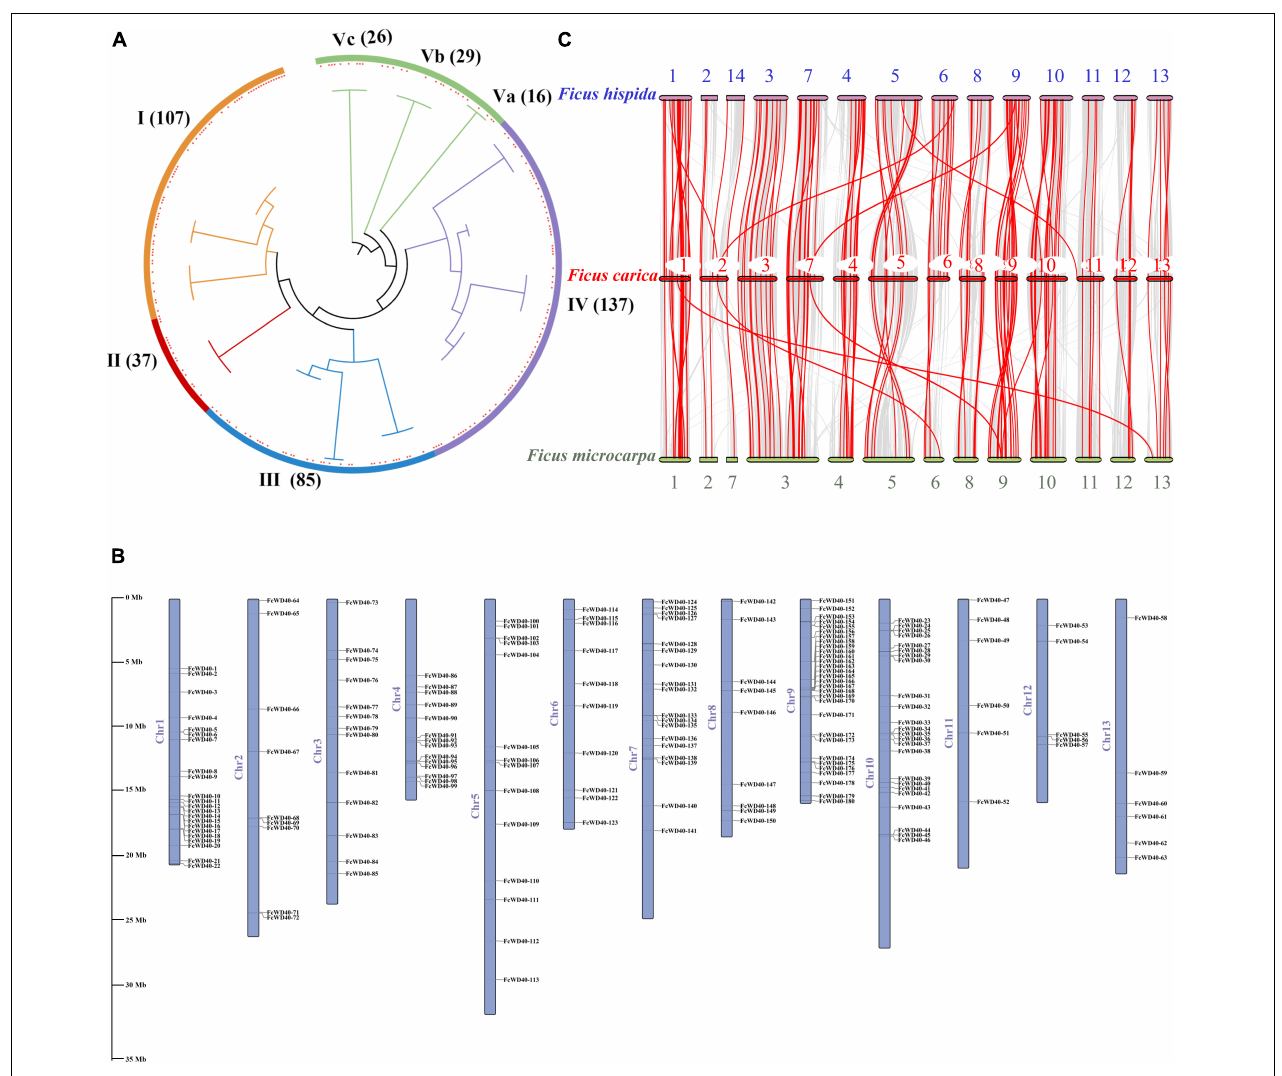
FIGURE 1 | Chromosomal locations, phylogenetic relationships, and collinearity analysis of the FcWD40 gene family. (A) Phylogenetic tree of 437 WD40 genes identified in Ficus carica and Arabidopsis thaliana genomes. Orange, red, blue, purple, and green highlighted areas show clusters I–V. Red squares represent fig WD40. The numbers on the branch points represent total number of WD40 gene; scale length represents genetic distance. (B) FcWD40 genes are marked on chromosomes; scale bar on the left indicates length of fig chromosome (Mb). (C) Collinearity relationship of WD40 genes among Ficus carica , Ficus hispida , and Ficus microcarpa . Identified collinear genes are linked by red